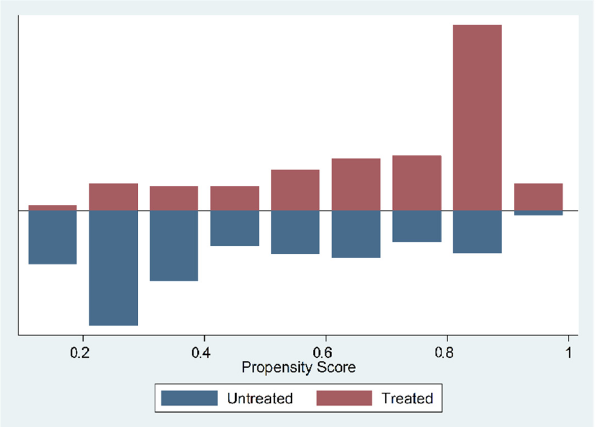
Figure 3. The coincidence of the sample propensity values of the post-matching treatment and control groups.